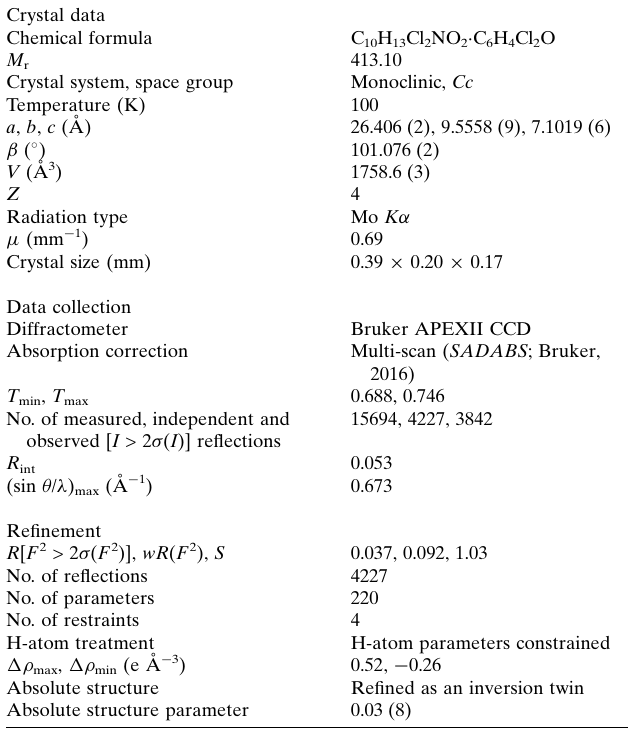
Crystal data Chemical